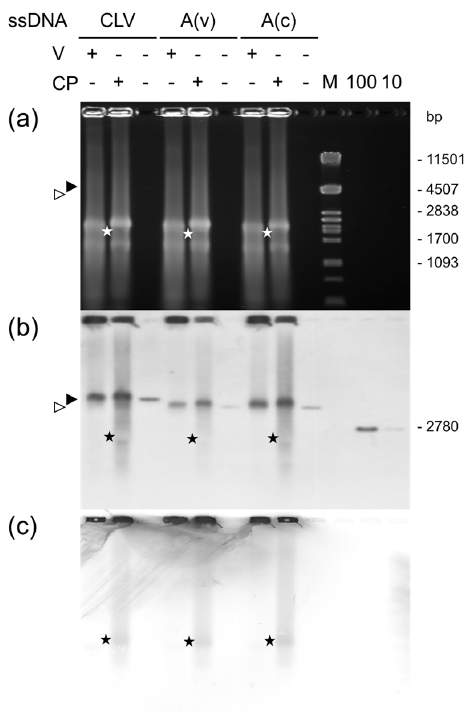
Figure 4. Interaction of CP with ssDNA. Extract supernatants from CP ‐ expressing (CP) or control cells (V) were incubated with ssDNA from pCLV1.3A (CLV), pBlue:ACMVA(v) (A(v)), or pBlue:ACMVA(c) (A(c)). Complexes or ssDNA alone were precipitated with polyethylene glycol and analyzed on an ethidium bromide stained 0.7% agarose gel ( a ) or, after blotting onto nylon ( b ) or nitrocellulose ( c ) membranes, for viral DNA or CP detection using hybridization with an ACMV DNA A ‐ specific probe ( b ) or an CP ‐ specific antibody ( c ), respectively. The corresponding positions of complexes with ssDNA and CP are indicated by asterisks, the positions of ssDNA by arrowheads. M: Pst I fragments of λ DNA with bp indicated. Hybridization standards: 100 and 10 pg of linearized full ‐ length ACMV DNA A (10, 100). Bands in ( a ): rRNA.